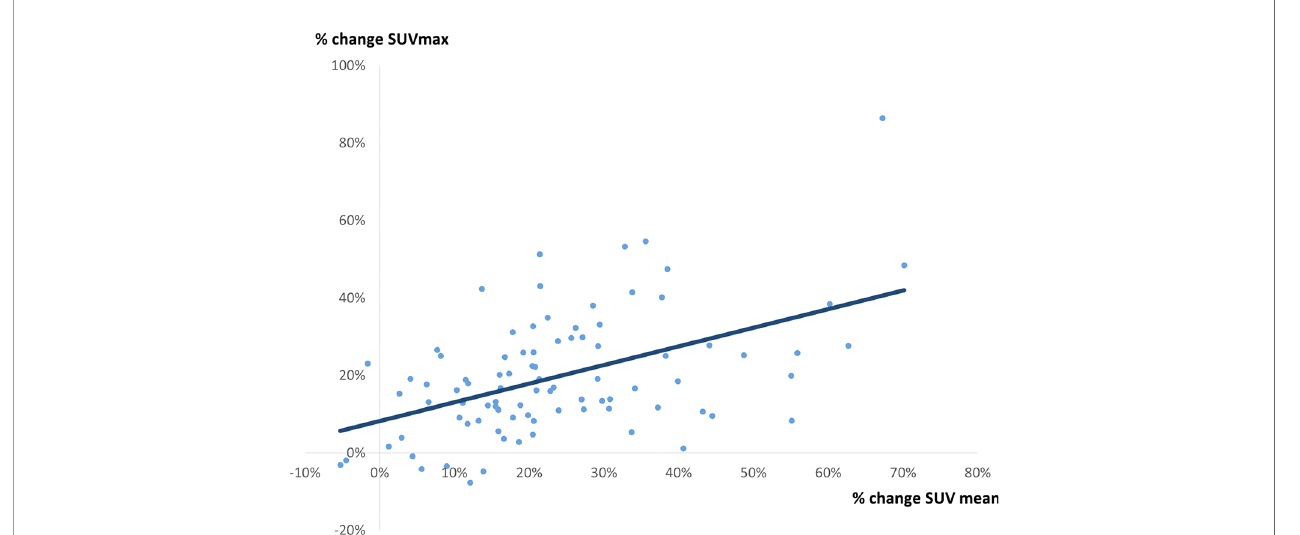
FIGURE 5 | A correlation between % change in SUV max and % change in SUV mean . A weak correlation was observed (r = 0.4891, p = 0.0897, y = 0.4815x +